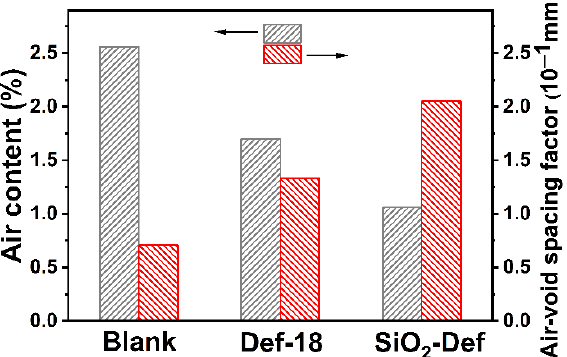
Figure 11. Air content and air-void spacing factor of the hardened cement mortar specimens containing Def-18 and SiO 2 -Def.